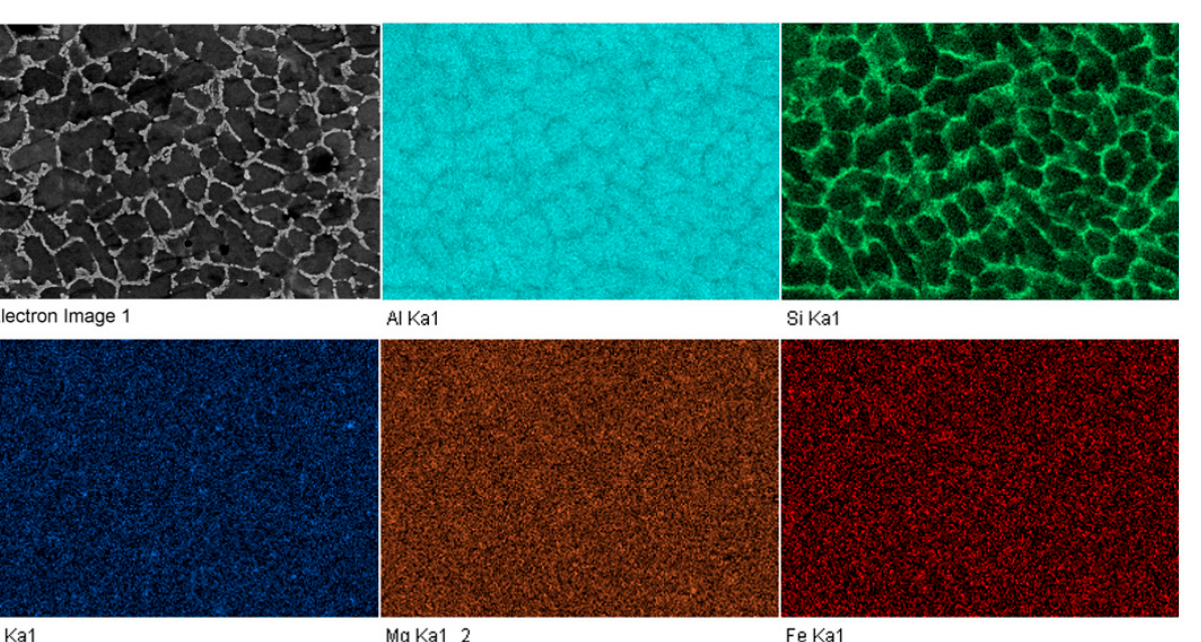
Figure 4. SEM analysis of the microstructure of as-built L-PBF AlSi10Mg sample in the transverse cross-section.